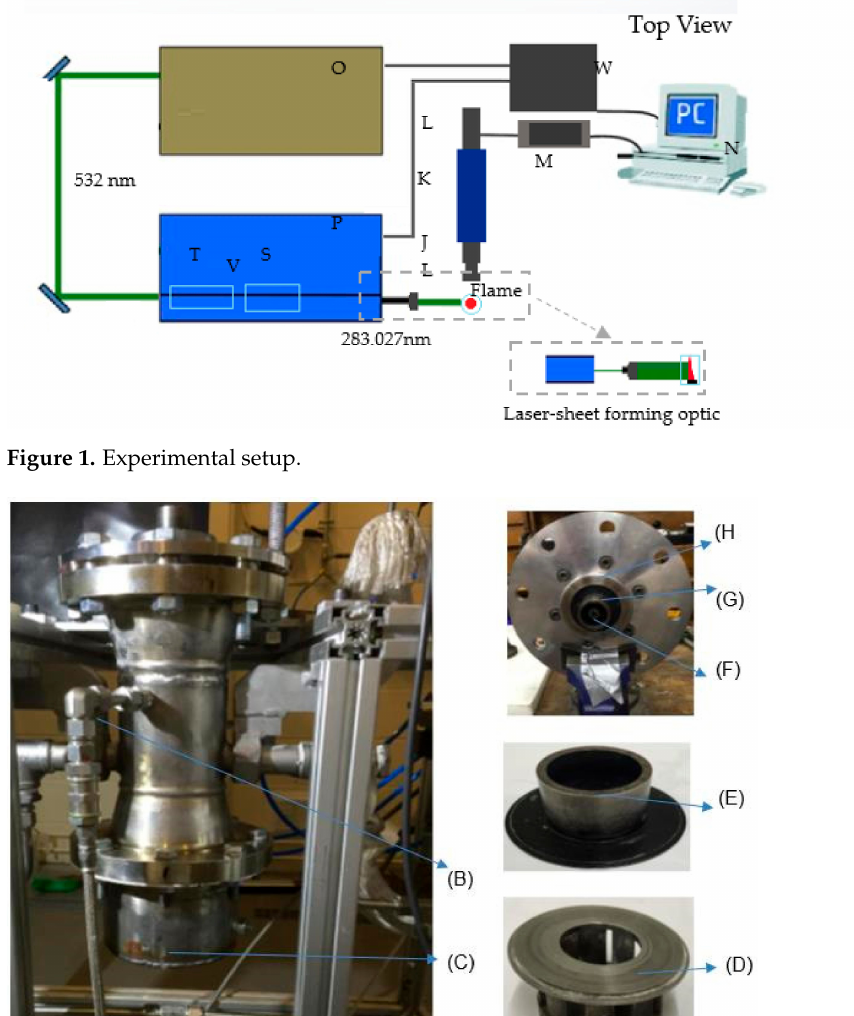
Figure 2. The 20-kW generic burner system: ( A ) working fluid intake, ( B ) fuel intake, ( C ) speaker container, ( D ) swirler, SN = 1.5, ( E ) swirler/burner nozzle, divergent angle = 90 ◦ , ( F ) diffusive injector, ( G ) swirl base, ( H ) confinement